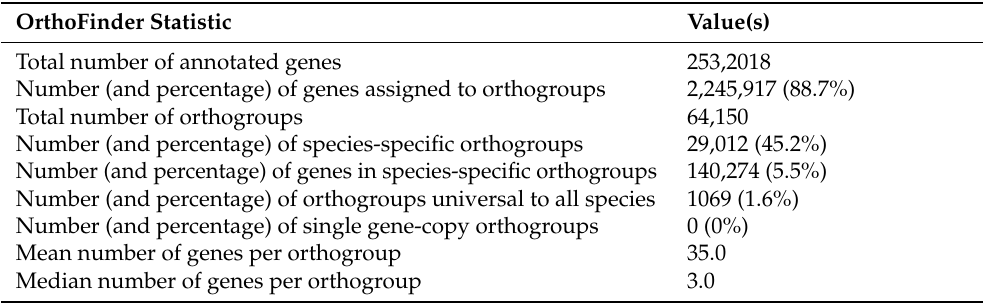
Table 2. Summary of OrthoFinder analysis to identify orthologous groups of genes from the tran- scriptomes and genomes of 75 Viridiplantae plant